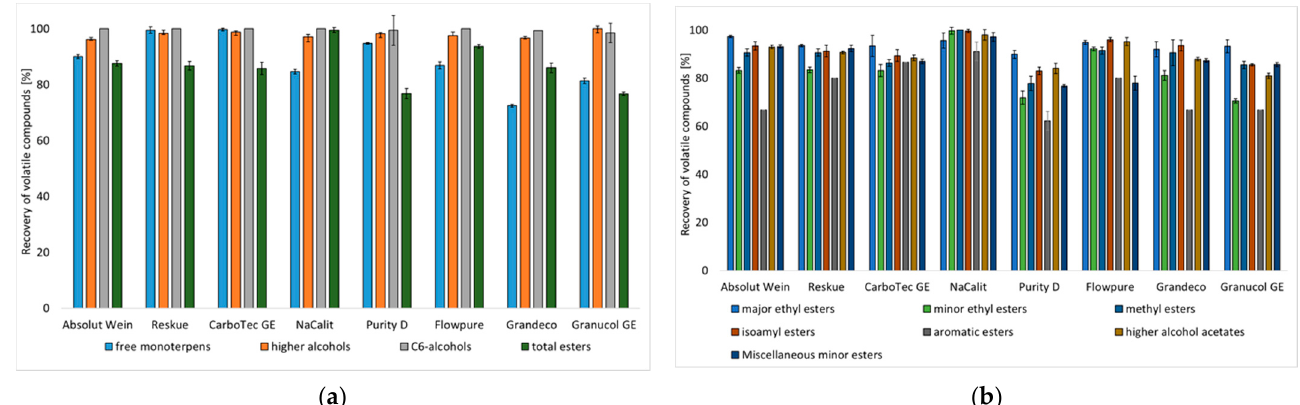
Figure 4. Recovery of volatile substances after fining in white wine; ( a ) main groups: free monoterpenes, higher alcohols, C6-alcohols and total esters; ( b ) specific ester groups: major ethyl esters, minor ethyl esters, methyl esters, isoamyl esters, aromatic esters, higher alcohol acetates, miscellaneous minor esters.